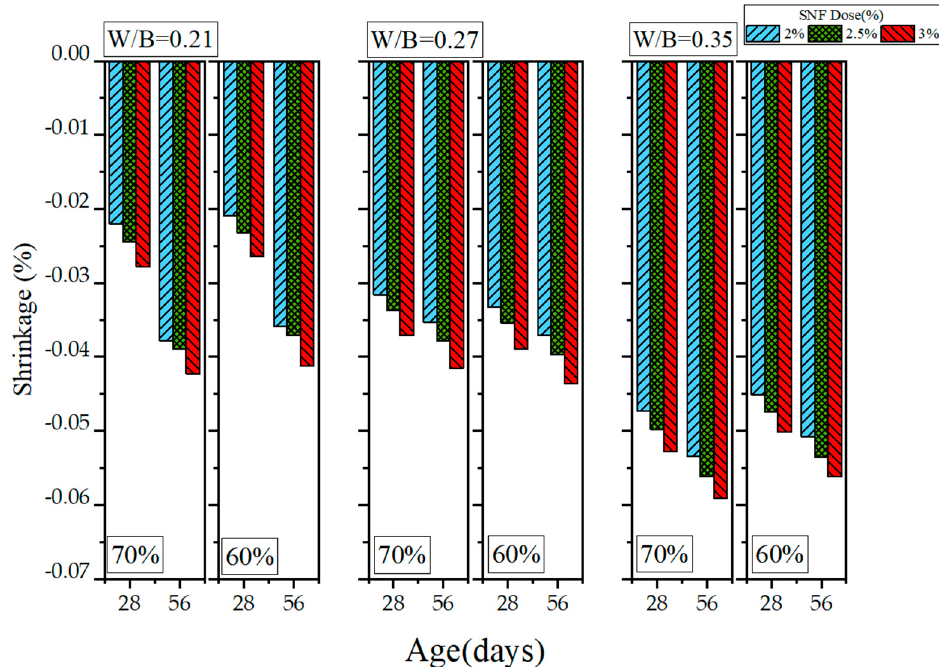
Figure 20. Length changes of green and ecofriendly grouting material with SNF.